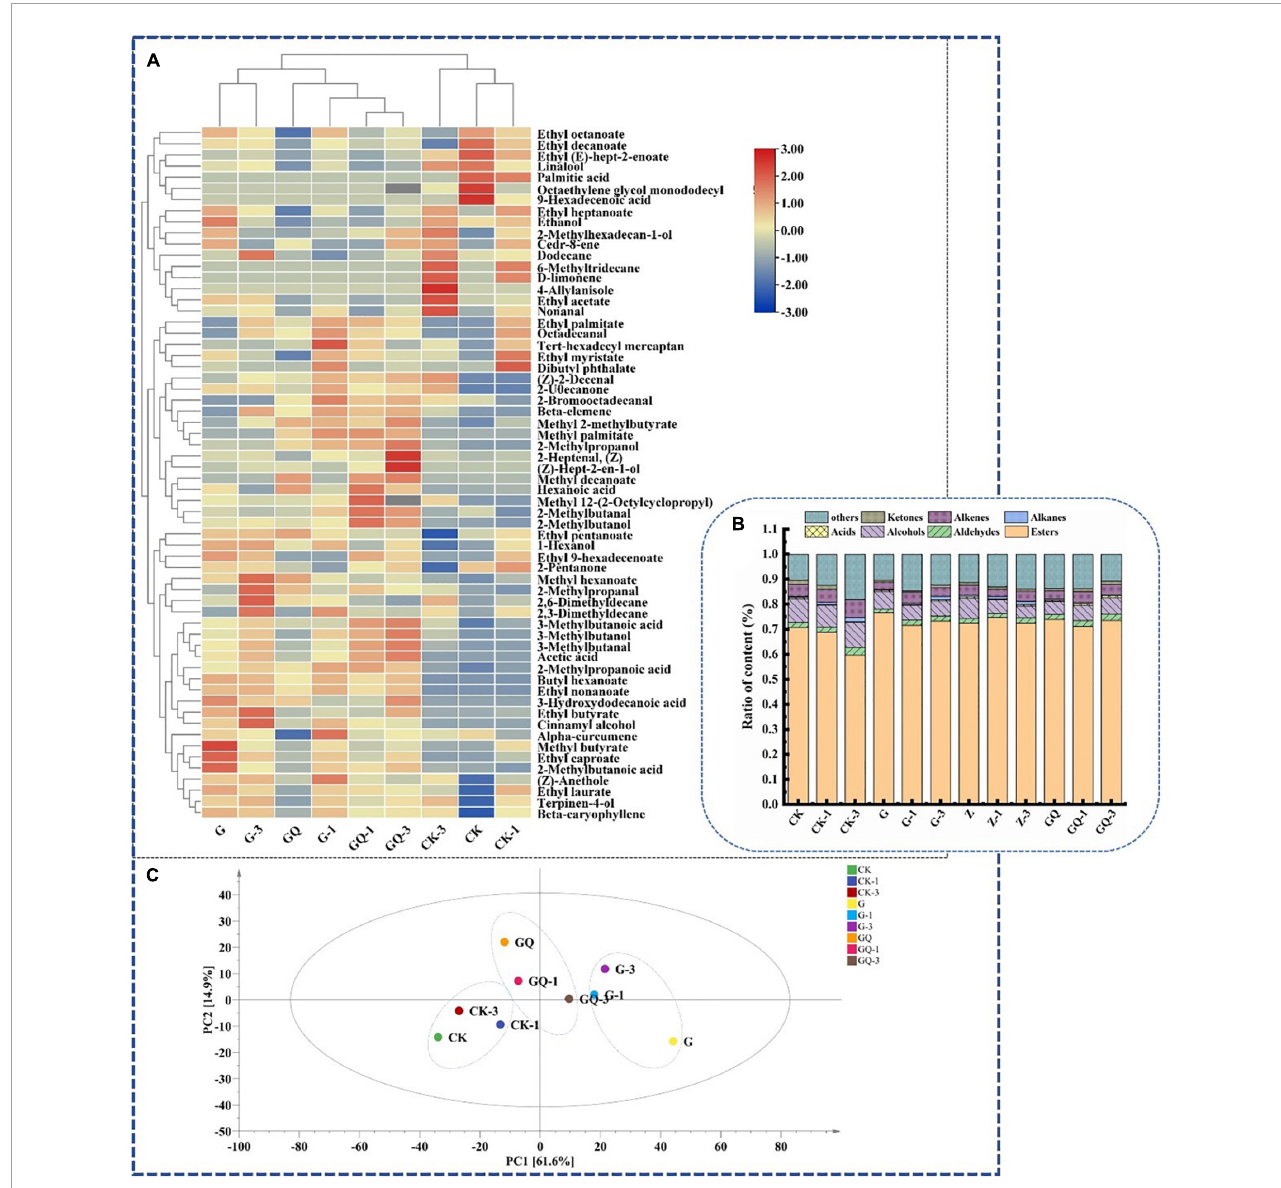
FIGURE6 The flavor profiles of fermented sausages, including heatmap (A) , composition of sausage flavors in the different groups (B) , and principal component analysis of flavor substances among treatments (C) at the end of fermentation (28 days). The group without starter culture and leucine was assigned to the CK group. The groups added with 1 and 3 mM of leucine without starter culture were assigned to the CK-1 and CK-3 groups, respectively. The group with Lactobacillus fermentum YZU-06 was assigned to the G group. The groups with Lactobacillus fermentum YZU-06 and different concentrations of leucine (1 and 3 mM) were named G-1 and G-3 groups, respectively. The fermented sausage with the mixed-starter cultures of Lactobacillus fermentum YZU-06 and Staphylococcus saprophyticus CGMCC 3475 was assigned to the GQ group. The groups with the mixed-starter cultures and